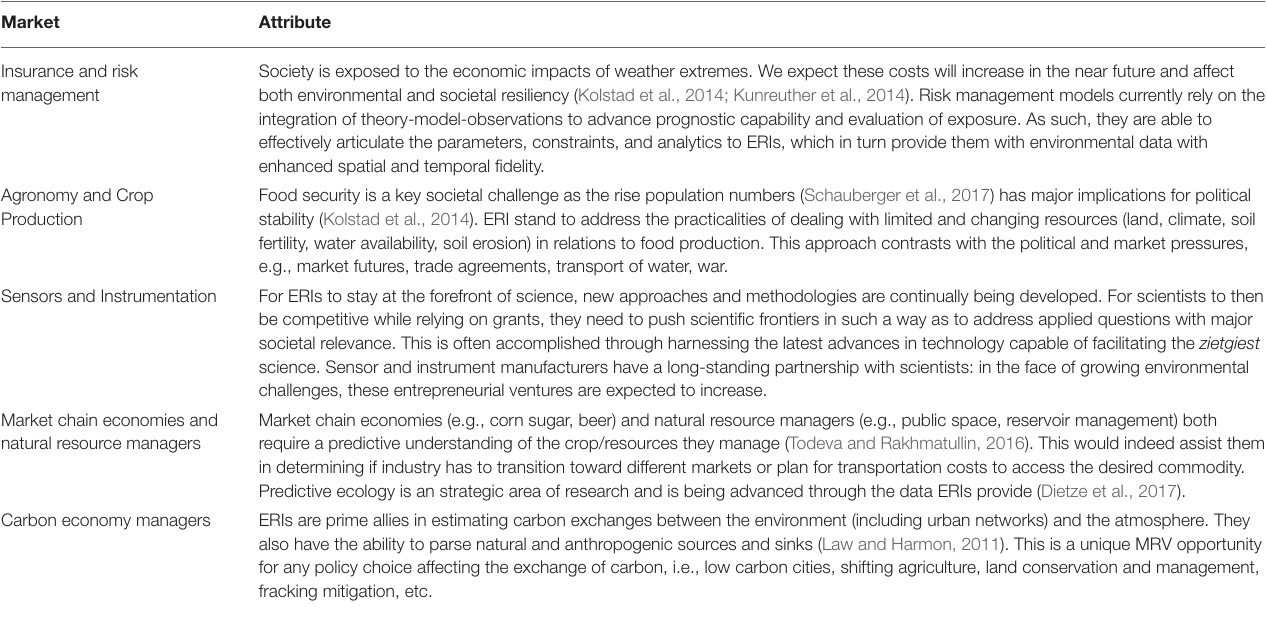
TABLE 2 | Key markets, early adopters, and their attributes. Market